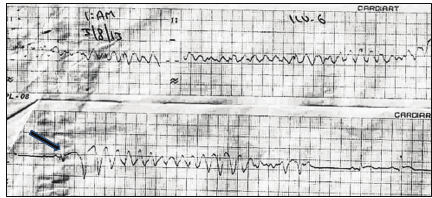
Figure 4: Same patient having polymorphic VT. Note the fusion complex prior to VT